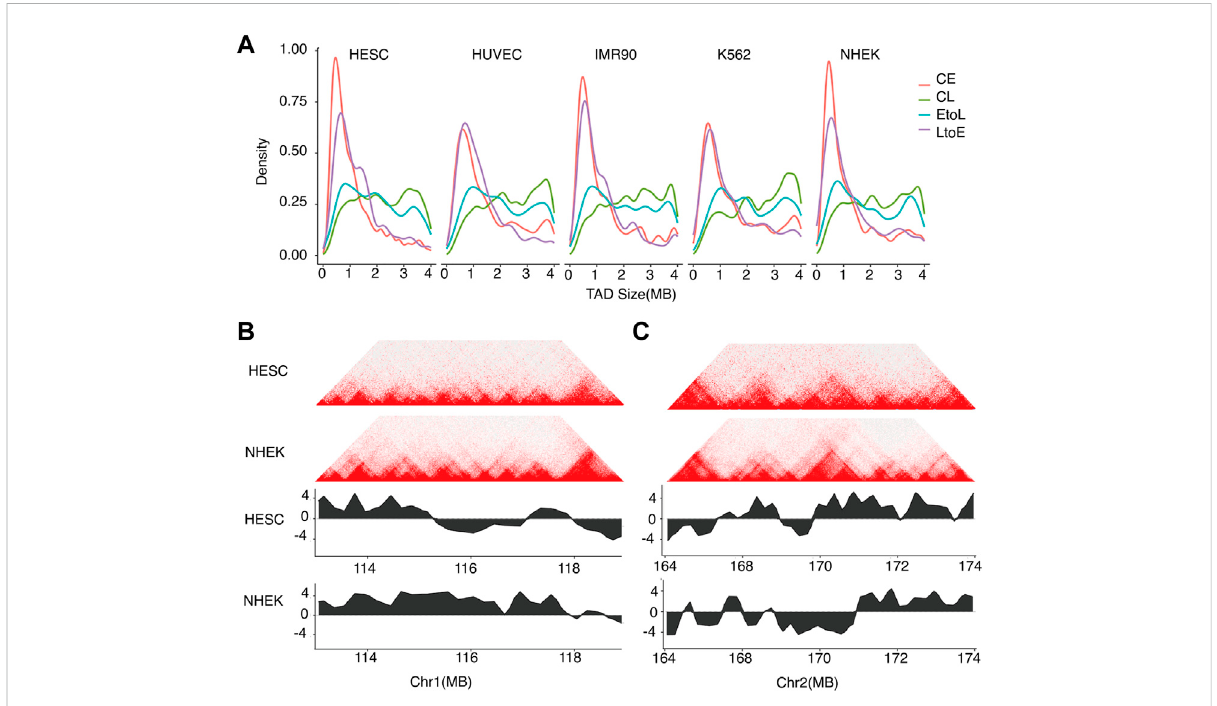
FIGURE 5 Sizes of TADs corresponding to different types of replication domains. (A) TAD size distributions of the four categories of RT regions for the fi ve cell types. (B) Typical example of TAD structure of an EtoL region on chromosome 1. Top: Hi-C contact heatmap for hESC and NHEK cells.